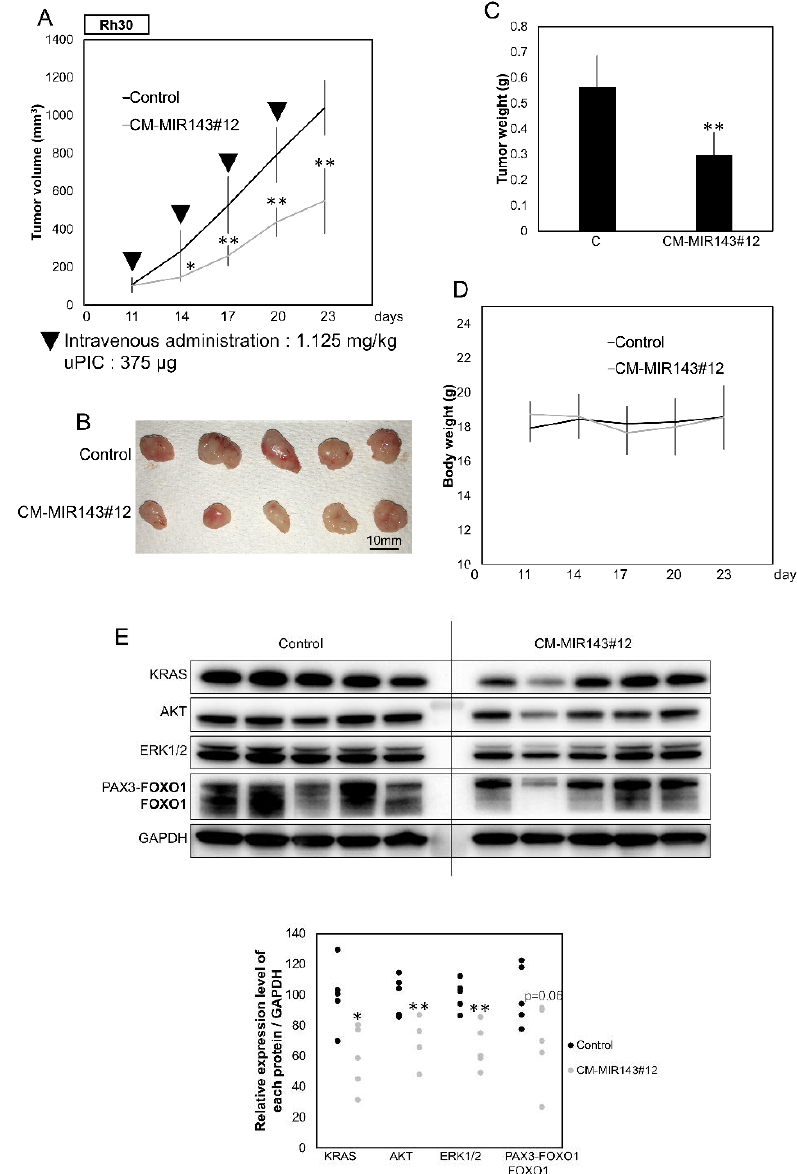
Figure 6. ( A ) Anti-tumor effect of CM-MIR143#12 on Rh30 cell xenografted-tumor model mice. The graph shows a time course of tumor size in mice injected with control RNA or CM-MIR143#12 ( n = 5). Arrowheads represent intravenous injections of control RNA or CM-MIR143#12 (1.125 mg/kg/administration) delivered using polyionic copolymers (PIC; 375 µg/administration) every 3 days. ( B ) Photo of tumors in treated and control groups. ( C ) Graph showing tumor weight. ( D ) Graph showing a time course of body weight of mice injected with control RNA or CM-MIR143#12. ( E ) Panel showing Western blot detection of KRAS, AKT, ERK1/2, and PAX3–FOXO1 proteins expressed in the tumor tissues treated with control RNA or CM-MIR143#12. Relative expression levels of each protein/GAPDH were calculated based on densitometric values of each protein and β-actin. PAX3–FOXO1 was detected using the antibody indicated in bold. Results are presented as the mean ± SD; * p < 0.05; ** p < 0.01.